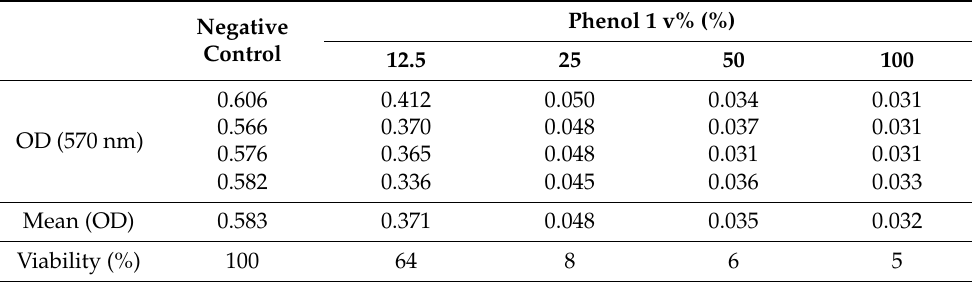
Table 6. OD and L929 cell viability values after 24 h of exposure to the positive